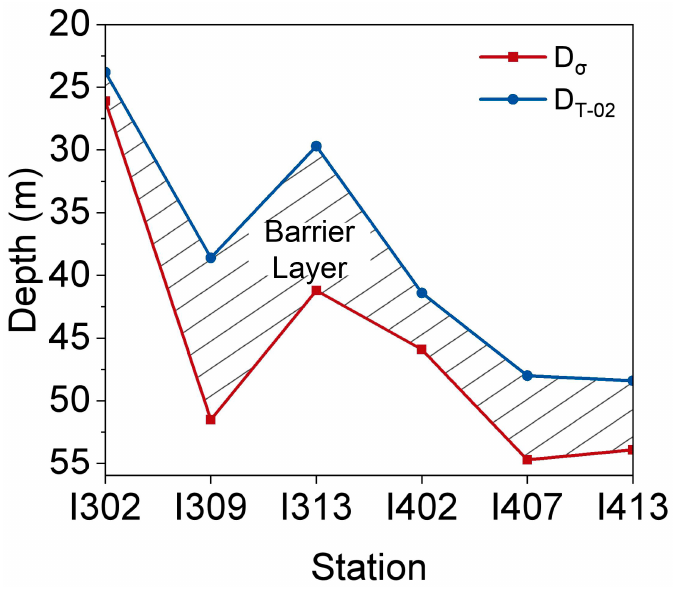
Figure 3. The barrier layer thickness of the equatorial eastern Indian Ocean. The blue line represents the Isothermal Layer Depth (ILD), determined by the definition of the depth where the temperature was 0.5 ◦ C below the surface temperature. The red line represents the Mixed Layer Depth (MLD), defined as the depth surface density plus the density difference brought about by the temperature increment of 0.2 ◦ C. The shaded area represents the barrier layer thickness determined by the difference between the ILD and MLD (D T-02 -D s ).